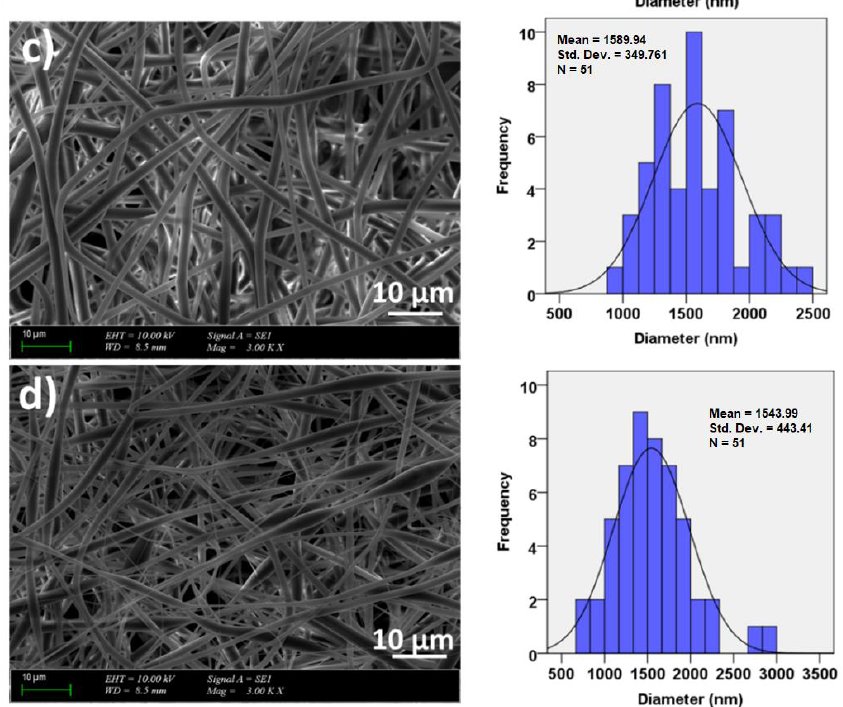
Figure 3. The SEM images of the PLA ( w / v ) ( a ), PLA ( w / v )/10 J ( b ), PLA ( w / v )/20 J ( c ), and PLA ( w / v )/30 J ( d ) scaffolds. ( w / v )/30 J ( d ) scaffolds.